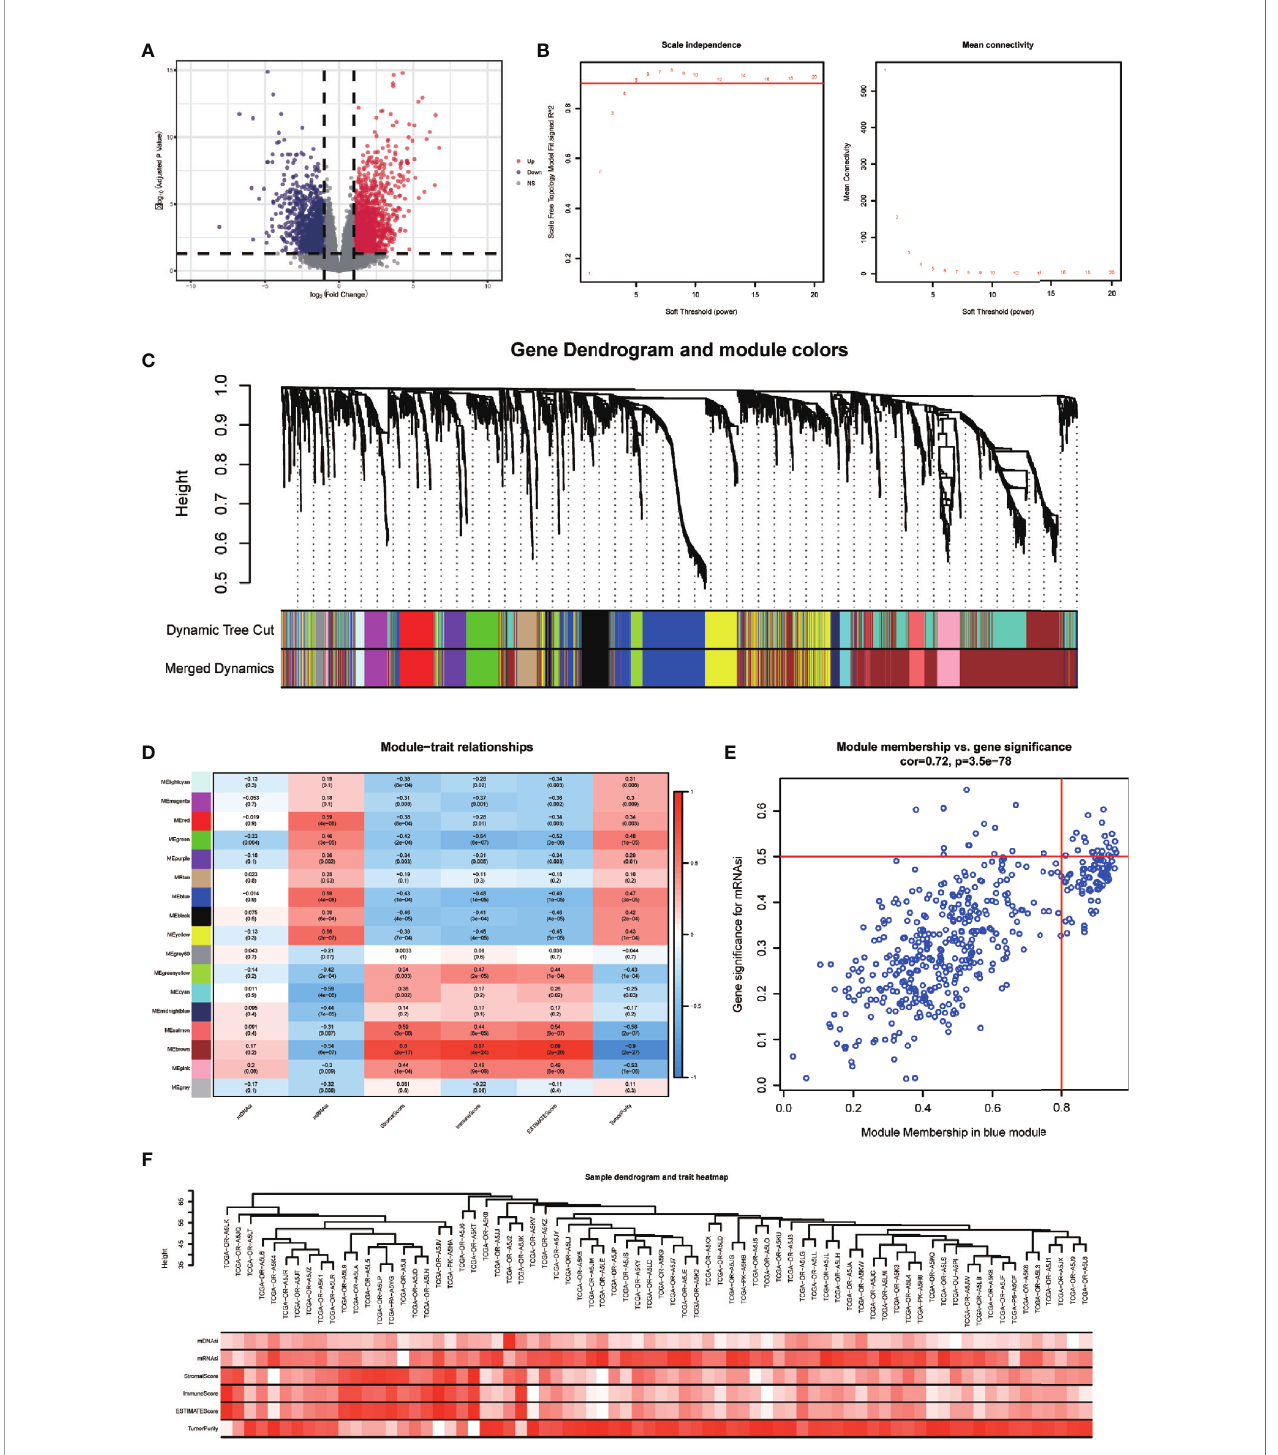
FIGURE 3 | Identi fi cation of stemness-related hub genes through WGCNA. (A) Volcano plots of DEGs between high-mRNAsi and low-mRNAsi groups. (B) Analysis of the scale-free fi t index for various soft-thresholding powers ( b ) and the mean connectivity for various soft-thresholding powers. (C) TOM cluster dendrogram of WGCNA: Branches with different colors corresponding to different modules. Dynamic Tree Cut represents the original module, while Merged Dynamic represents the fi nal module. (D) Correlation of traits (mDNAsi, mRNAsi, ESTIMATEScore, StromalScore, ImmuneScore, and TumorPurity) with modules. Colors representing a gene set, the correlation coef fi cient, and P-value have been marked. (E) Scatter plot of module eigengenes in the blue module with cut-offs of MM > 0.8 and GS > 0.5. (F) Heatmap of the clustering of 78 ACC